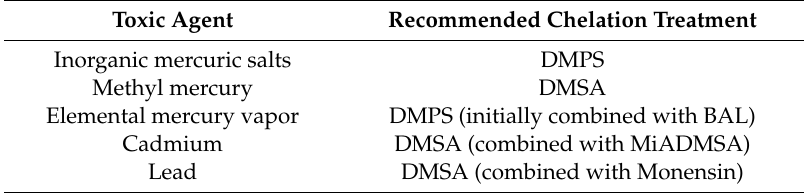
Table 5. Recommended chelation treatment in poisonings with mercury, cadmium, and